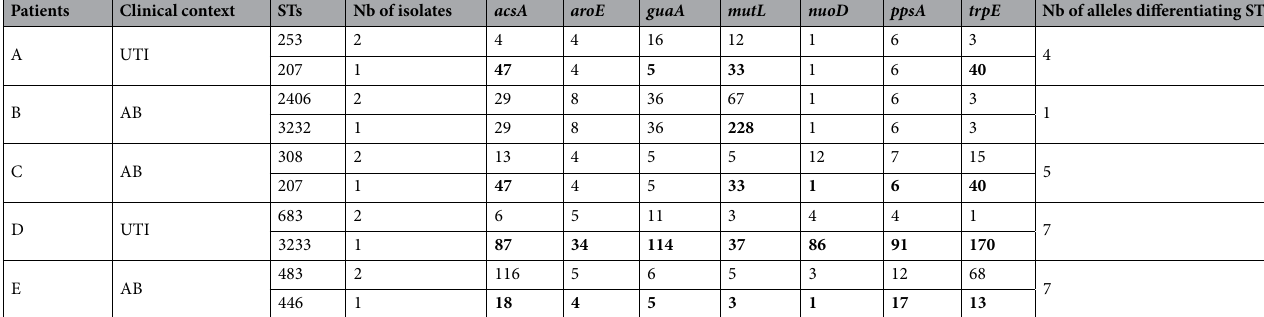
Table 2. Allelic profiles of P. aeruginosa isolates from patients with polyclonal urinary tract infection or asymptomatic bacteriuria. The seven alleles ( acsA , aroE , guaA , mutL , nuoD , ppsA and trpE ) that defined sequence type (ST) are indicated here. Alleles that differ between the 2 STs of the isolates of a given patient are in